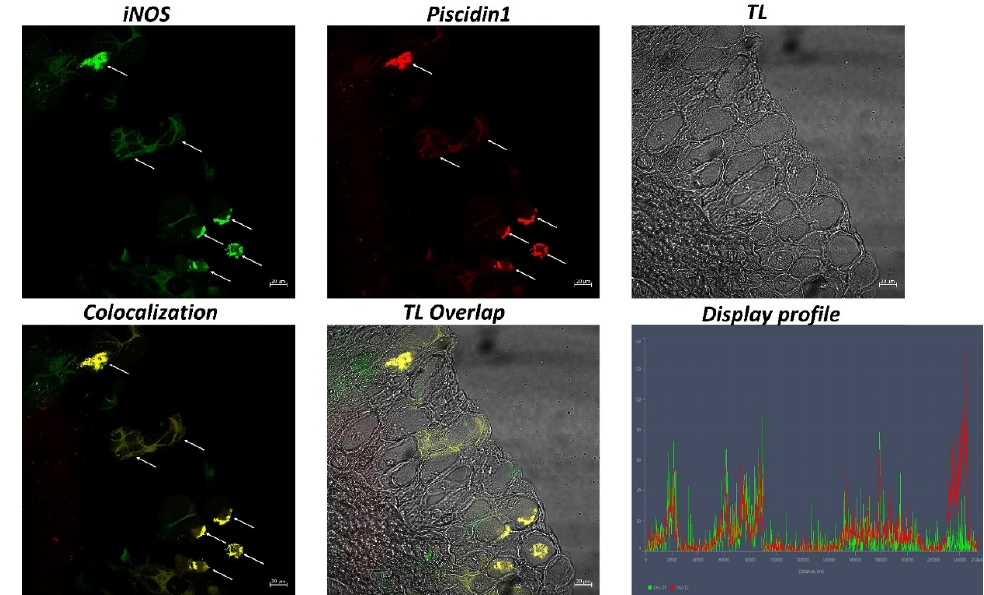
Figure 3. Immunofluorescence of iNOS and Piscidin1 in the intestine of hagfish, 40×, scale bar 20 nm. Immunopositivity of goblet cells to iNOS (green) and Piscidin1 (red) is noticeable (arrows). The colocalization of the two antibodies is confirmed by the “display profile” function. TL = transmitted light. Quantitative analysis revealed an equivalence of the number of goblet cells detected with the various antibodies (Table